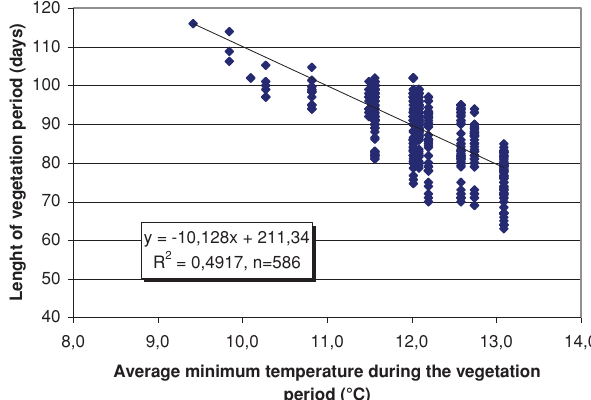
Figure 7. Relationship between length of vegetation period and minimum temperature of vegetation period, (Újfehértó, 1984–2001)